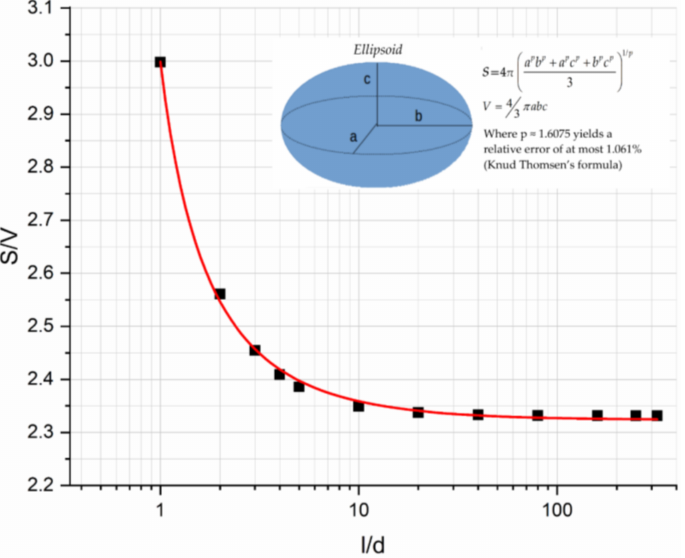
Figure 11. Ellipsoid inclusion area per unit volume as a function of the aspect ratio l / d